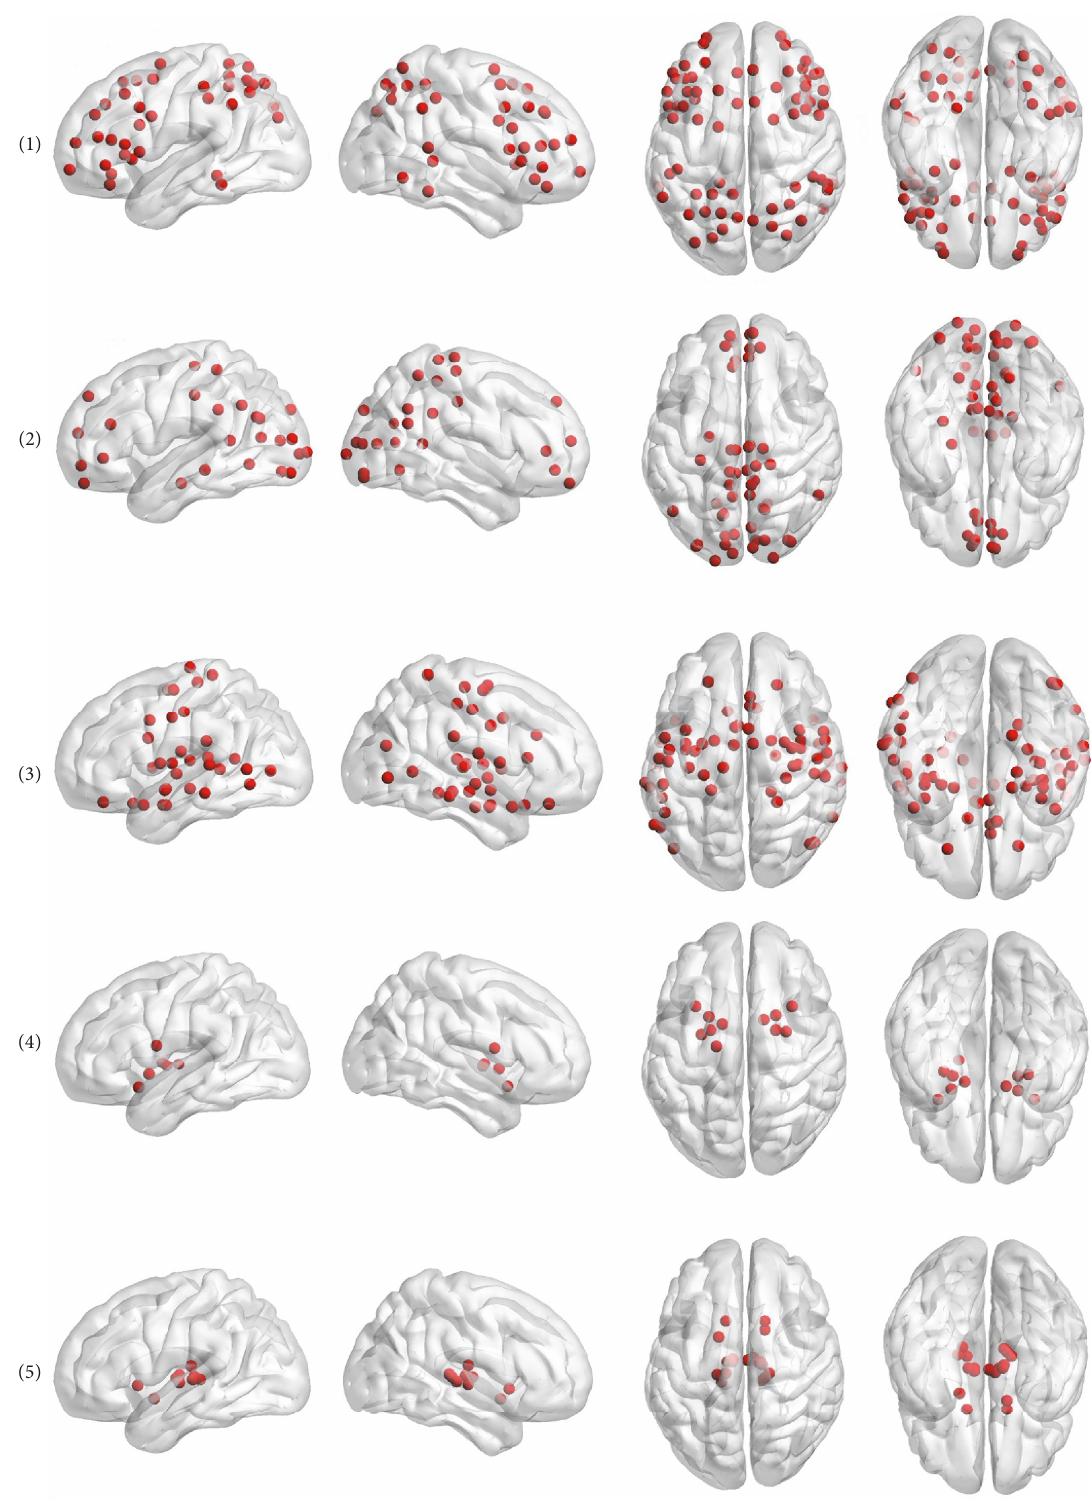
Figure 3: The five group level functional communities detected in SYNC networks. In each row, a single community is shown in four brain views (left side, right side, top side, and bottom